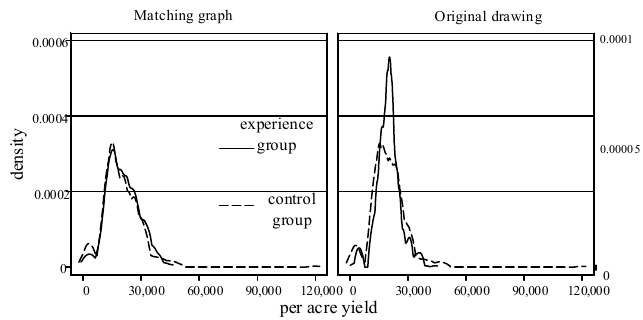
Figure 5. Average yield balance test per acre.